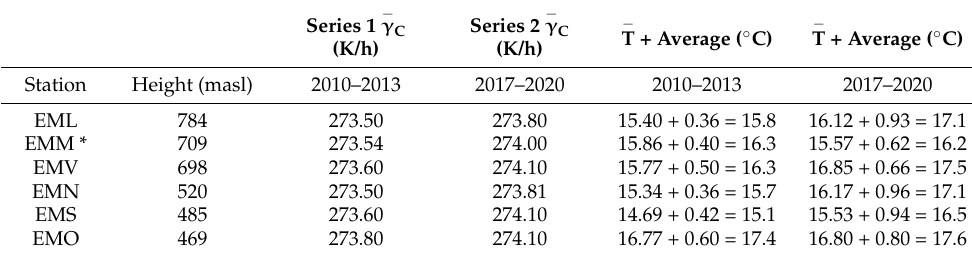
− γ Table 5. Presents a summary of C according to locality (commune), height (referred to sea level), average temperature and the increase in temperature per period. The values in columns 5 and 6 were approximated.